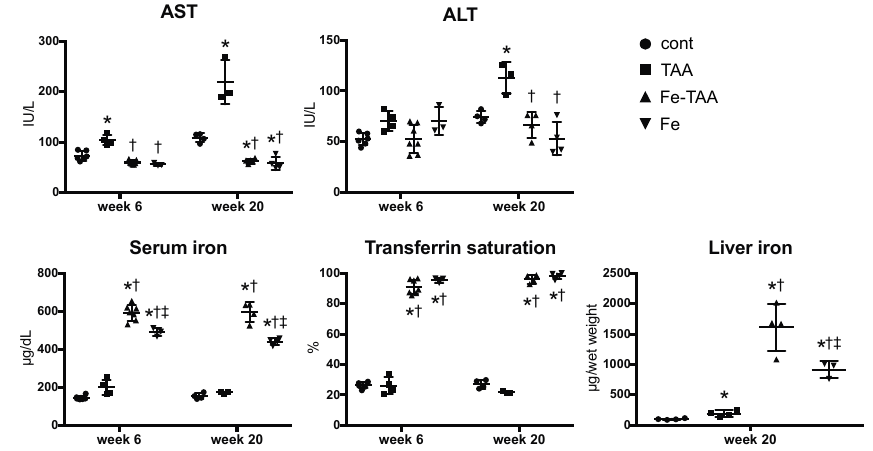
Figure 1. Biochemical data of serum aminotransferase (ALT), aspartate aminotransferase (AST), iron, transferrin saturation at weeks 6 and 20 and liver iron content at week 20. Data are expressed as mean ± standard deviation (SD). * p < 0.05 vs. control; † vs. thioacetamide (TAA); ‡ vs. Fe-TAA at the same time point, by Sidak’s multiple comparison.